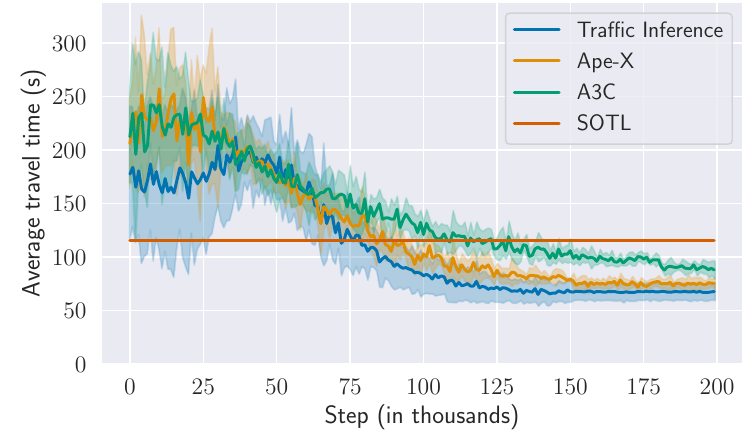
Figure 5. Convergence speed of RL